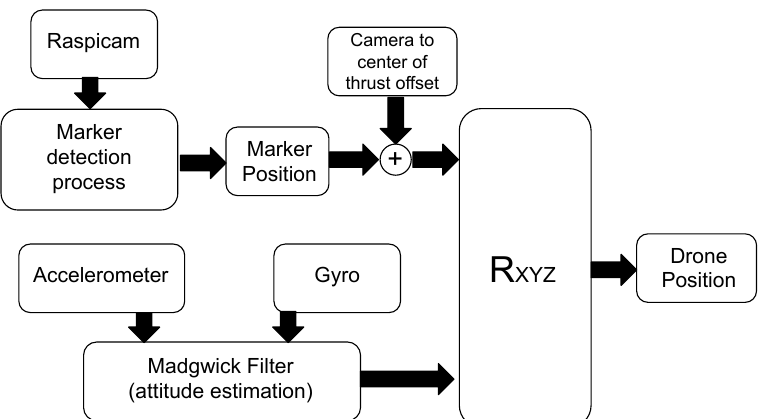
Figure 9. Schematic representation of the algorithm “Fixed Camera Frame Madgwick Filter” (FCF- MF). Unlike the algorithm FCF-CF, only the data stream from the accelerometer and the gyroscope are sent as input signals to the Madgwick sensor fusion filter. The latter provides an estimate of the drone orientation, whose precision does not depend on the distance between the drone and the marker.